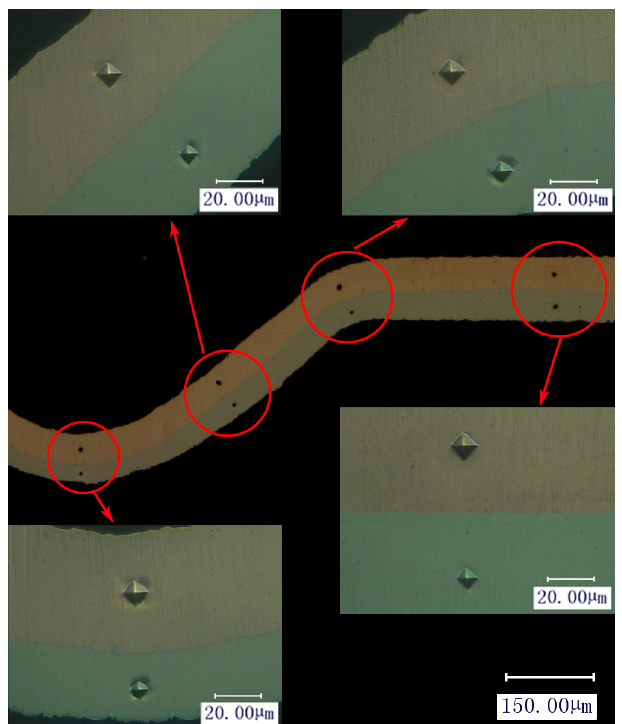
Figure 14. Measurement locations of micro-hardness.